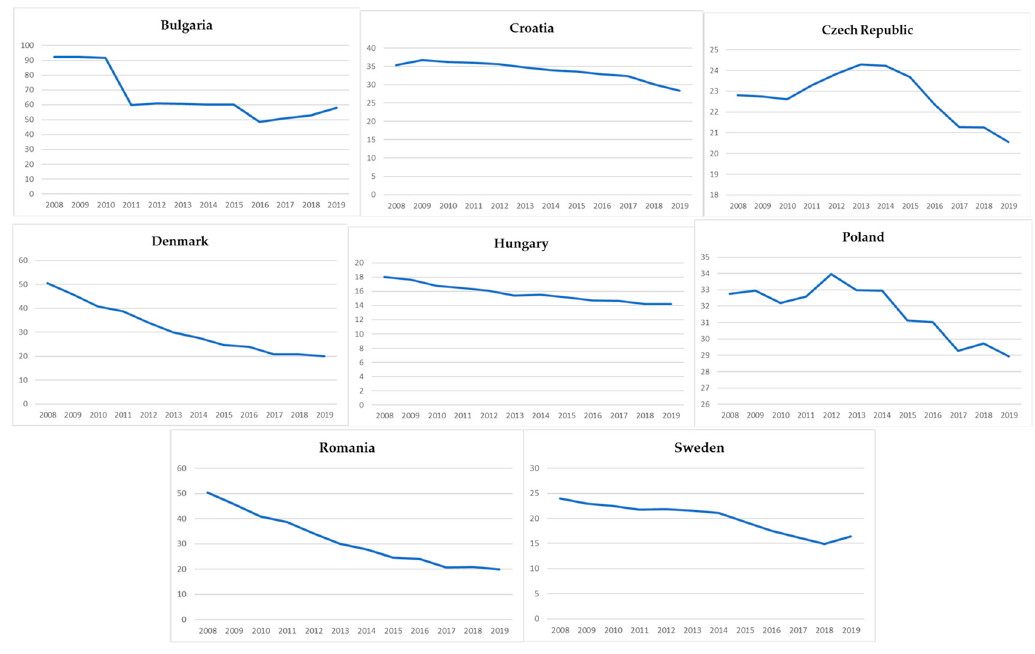
Figure 1. Bank branches per 100,000 adults in noneuro countries during 2008–2019.